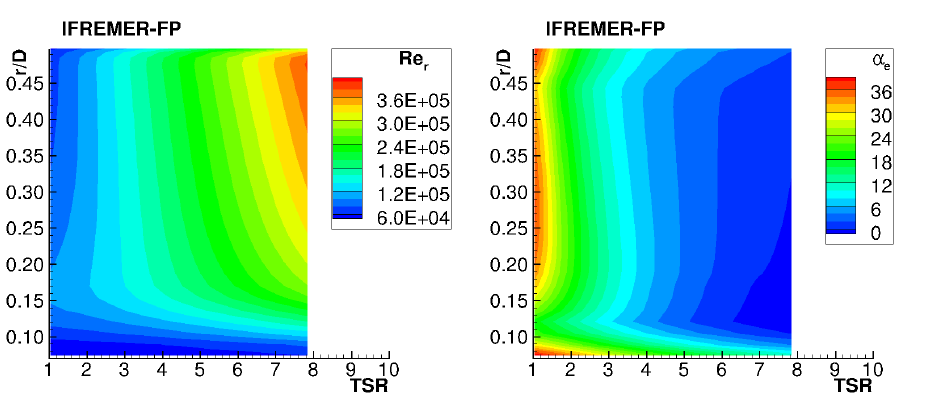
Figure 9. IFREMER-FP turbine. Reynolds number Re r ( left ) and effective angle of attack α e ( right ) as a function of radius r and of TSR .